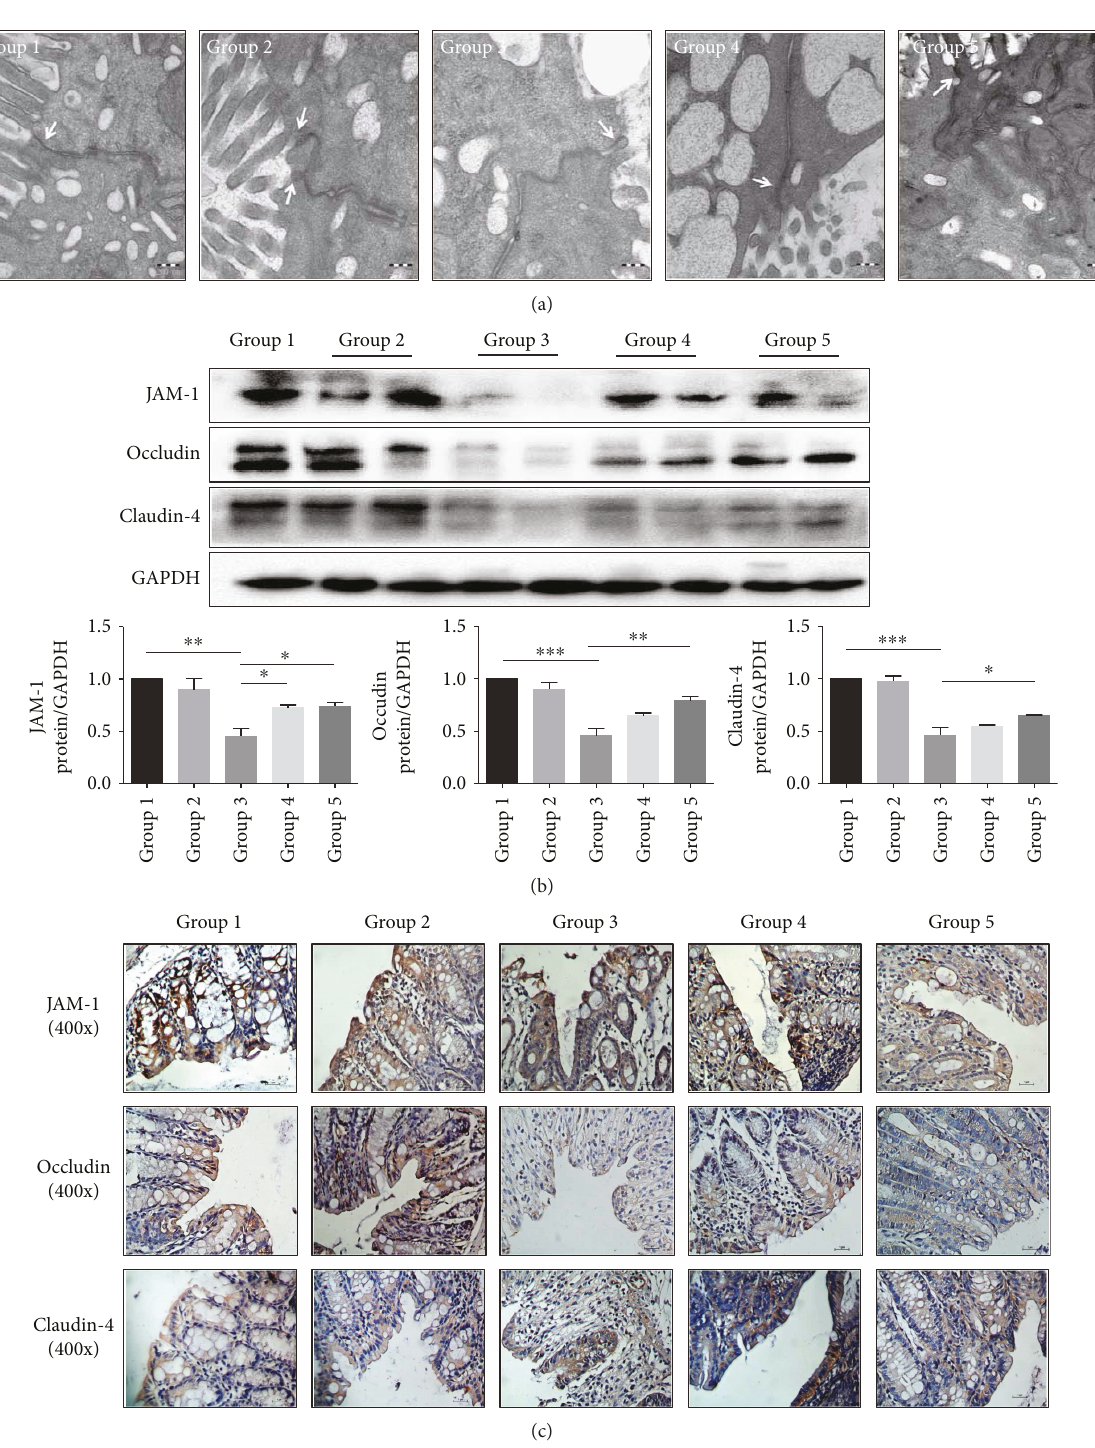
Figure 4: The e ff ect of Bi fi co on the expression and distribution of TJs (a). Microstructural changes in colonic tissues of each group by TEM (80000x magni fi cation) (b) The expressions of JAM-1, occludin, and claudin-4 were detected by Western blot. Group 1 ( n = 3 ), group 2 ( n = 6 ), group 3 ( n = 6 ), group 4 ( n = 6 ), and group 5 ( n = 6 ). (c) The expressions and distribution of TJs (JAM-1, occludin, and claudin-4) were analyzed by immunohistochemistry (400x magni fi cation). Data are means ± SEM . ∗ P < 0 05 , ∗∗ P < 0 01 , and ∗∗∗ P < 0 001 . Group 1: normal; group 2: Bi fi co ; group 3: colitis; group 4: pretreated- Bi fi co -colitis; group 5: pretreated +treated- Bi fi co